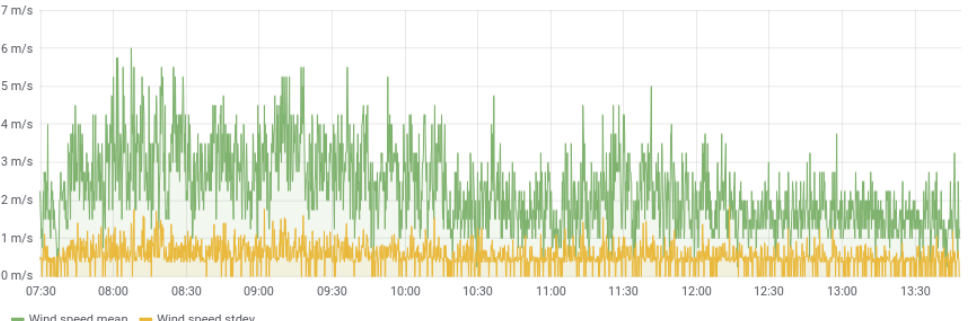
Figure 8. Mean wind speed and standard deviation.